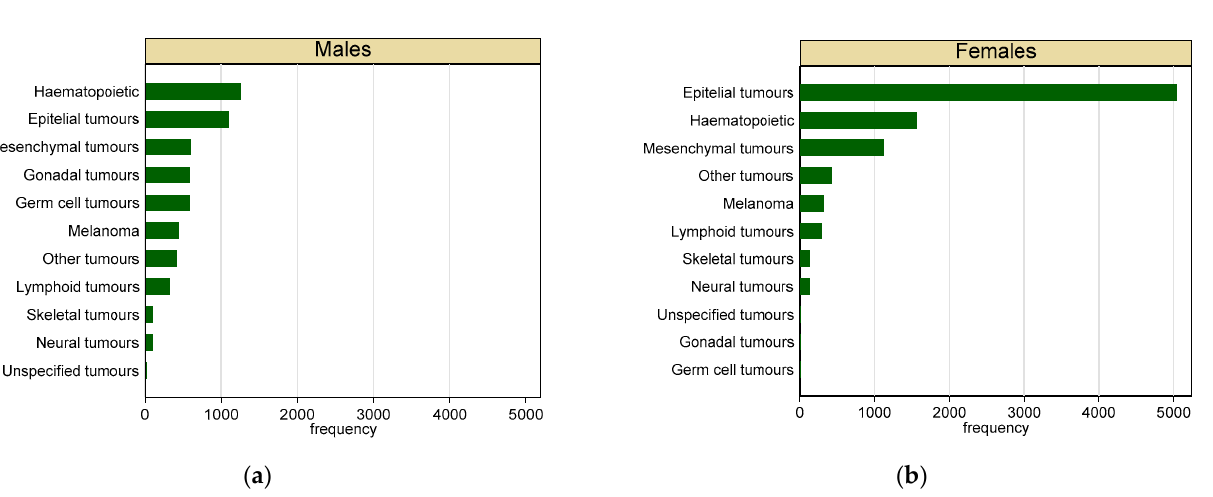
Figure 3. Frequency of malignant tumours in dogs by sex and topography; ( a ) males, ( b ) females.